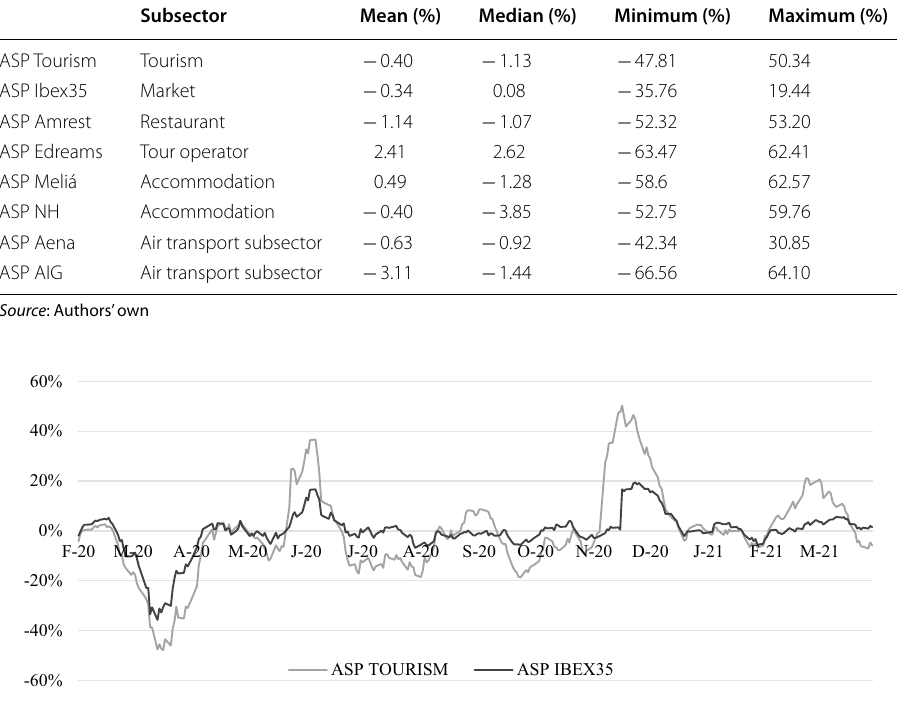
Fig. 3 Abnormal stock prices of the tourism sector and the Ibex35 (February/2020–April/2021). Source : Madrid Stock Exchange